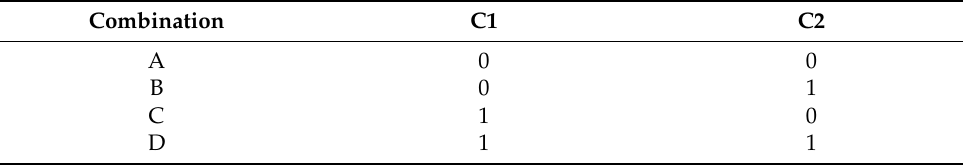
Table 2. Capacitor bank combinations (“1”: Connected, “0”: Not connected).